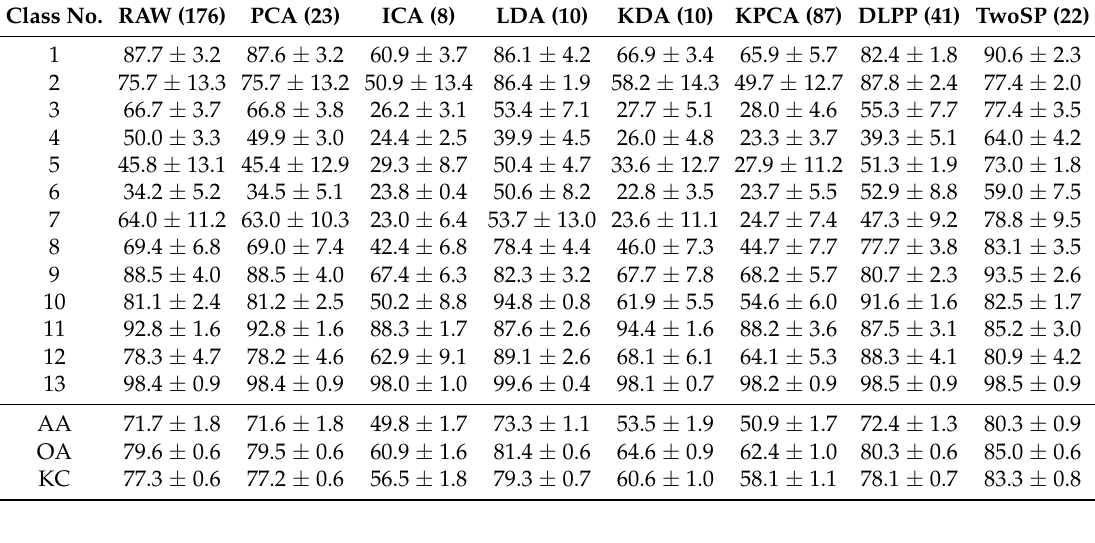
Table 3. Performance (%) of different methods (with the best reduced dimensionality in brackets) on the KSC dataset using the NN classifier.